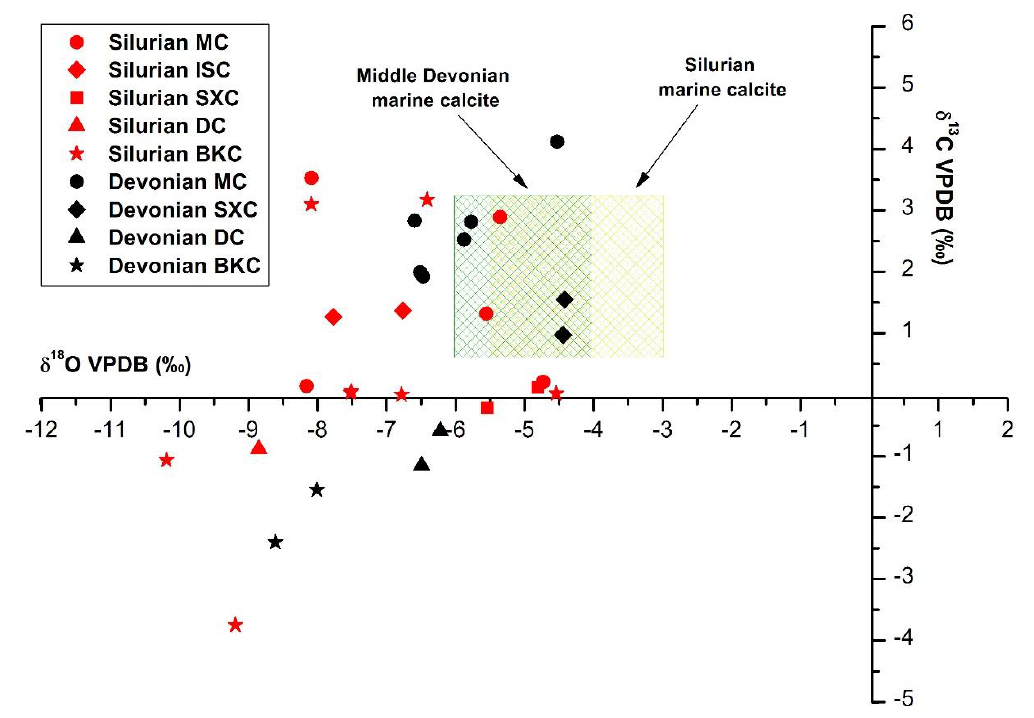
Figure 11. Crossplot of δ 13 C vs δ 18 O of different generations of calcite cement in Silurian and Devonian formations. Most of the calcitic samples show δ 13 C values, in range with postulated values for marine calcite of the respective age with the exception for late BKC which clearly shows a negative shift from the equilibrium values in both age groups. This may suggest a separate input of oxidized organic carbon possibly related to interaction with hydrocarbons. The green box represents isotopic values of the Middle Devonian marine calcite [49] and the yellow box represents the estimated isotopic values for the Silurian marine dolomite [50].